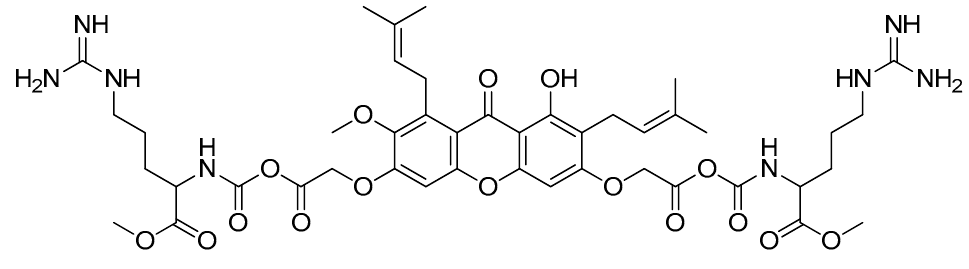
Figure 25. Arginine-OMe-mangostin. Table 13. In vitro antibacterial activity of amino-acid-modified α -mangostin. ( 1 ) α -Mangostin; ( 2 ) α -mangostin-OMe-lysine; ( 3 ) α -mangostin-OMe-histidine; ( 4 ) α -mangostin-OMe-arginine; ( 5 ) α -